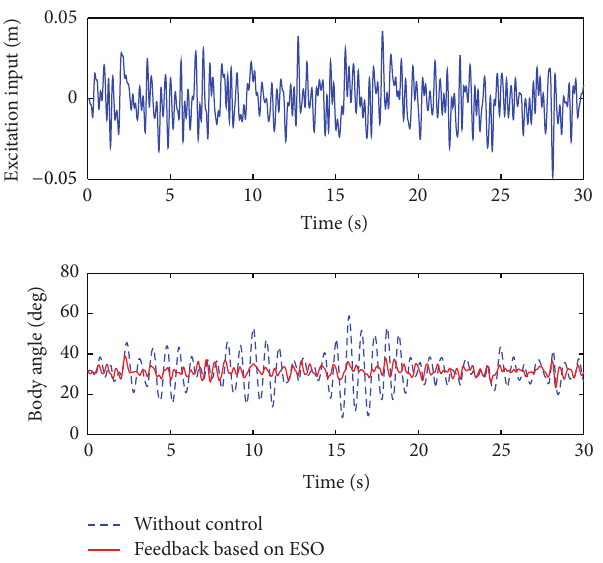
Figure 6: Random sequence excitement input simulation results.